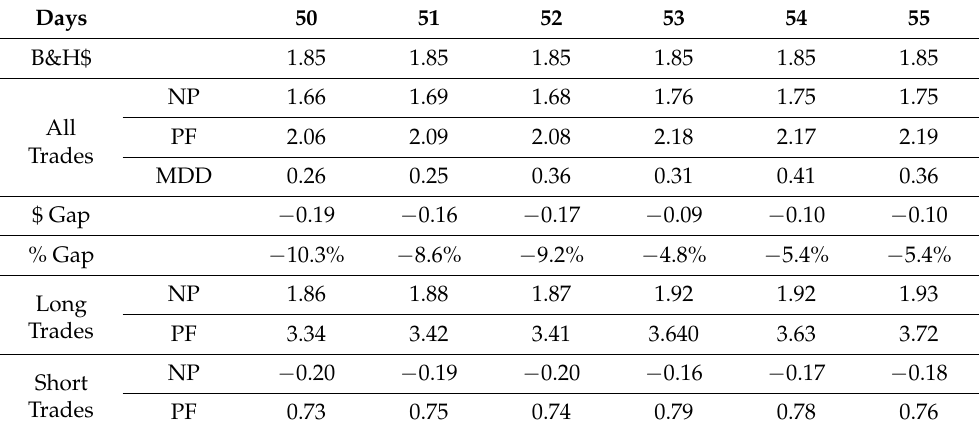
Table 5. Results for Cardano trades.